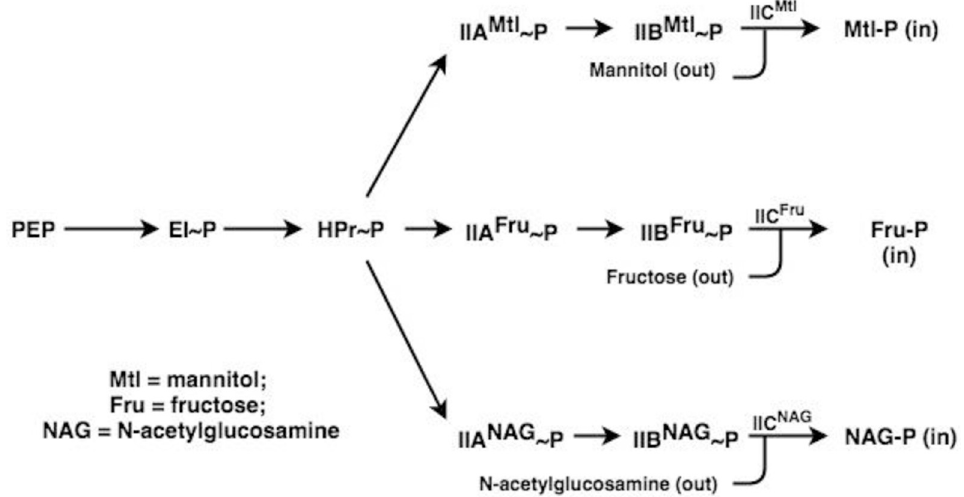
Fig 1. Phosphoryl transfer pathway for the bacterial phosphotransferase system (PTS). The figure shows the transfer of a phosphoryl group from phosphoenolpyruvate (PEP) to enzyme I (EI), then to HPr, then to the sugar-specific enzyme IIAs and then to the enzyme IIBs before transfer to the incoming sugar via the enzyme IIC, which catalyzes both transport and phosphoryl transfer in a coupled process. The PTS also catalyzes the group translocation of many other sugars. As indicated, the three extracellular sugars represented are mannitol (Mtl), fructose (Fru), and N- acetylglucosamine (NAG), and their phosphorylated derivatives are released into the cytoplasm. Arrows indicate the pathways of phosphoryl